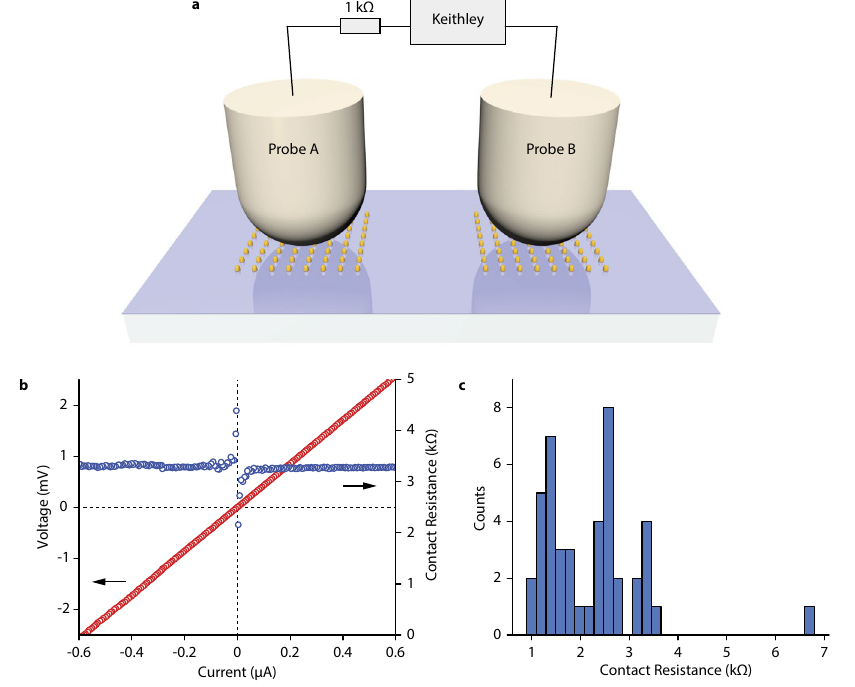
Figure 4. Measurements of shunt resistance between nanodots. ( a ) Schematic of the measurement setup. ( b ) A typical V-I curve and the calculated probe contact resistance measured on two arrays with quantized relative near-infrared transparency. ( c ) Histogram of measured probe contact